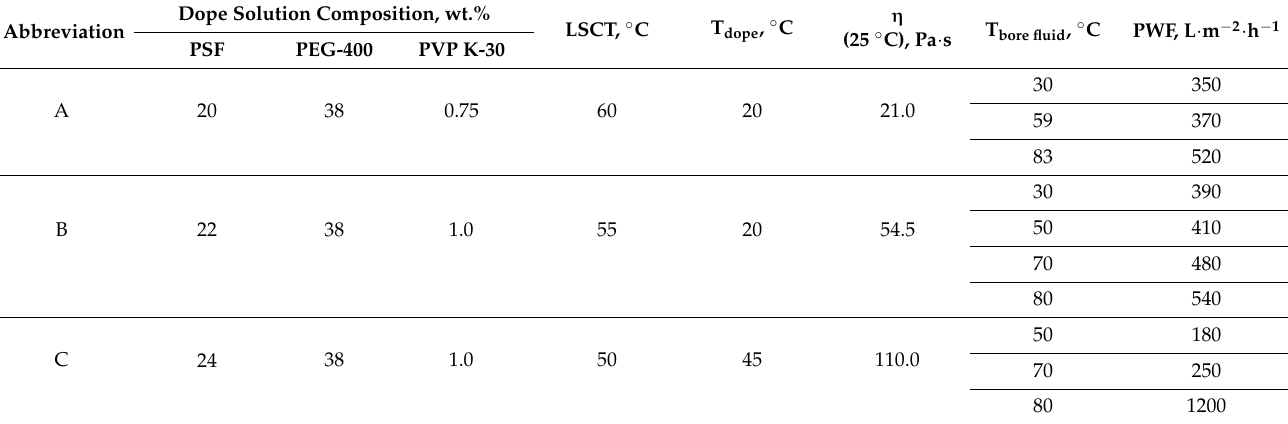
Table 2. Dope solution compositions, conditions of the hollow fiber membrane formation and membrane performance. The relative error for PWF is ≤